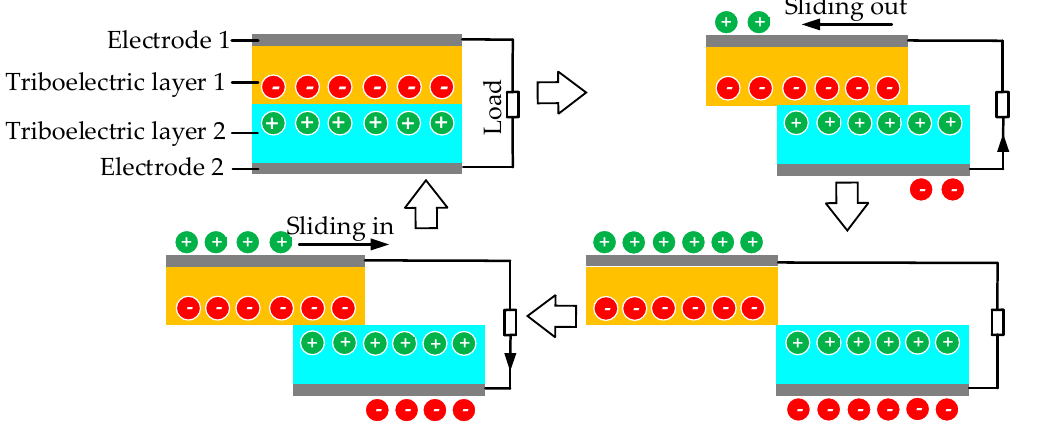
Figure 13. Working principle of the triboelectric effect.